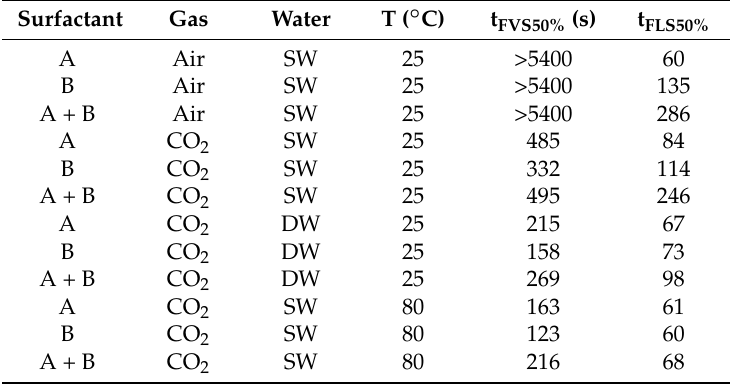
Table 2. Half-life time of different foam